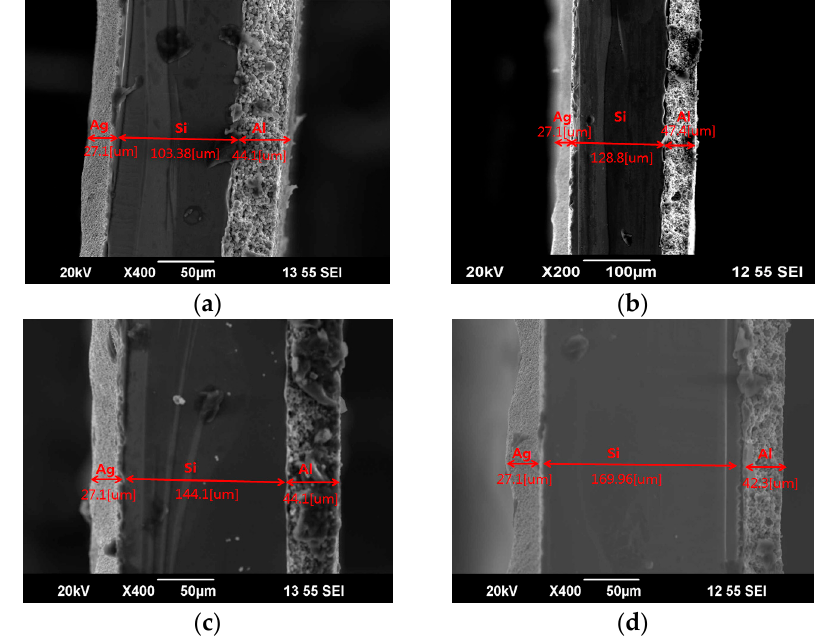
Figure 10. SEM measurement result according to wafer thickness. ( a ) SEM measurement result of 120 μ m c-Si solar cell; ( b ) SEM measurement result of 140 μ m c-Si solar cell; ( c ) SEM measurement result of 160 μ m c-Si solar cell; ( d ) SEM measurement result of 180 μ m c-Si solar cell.